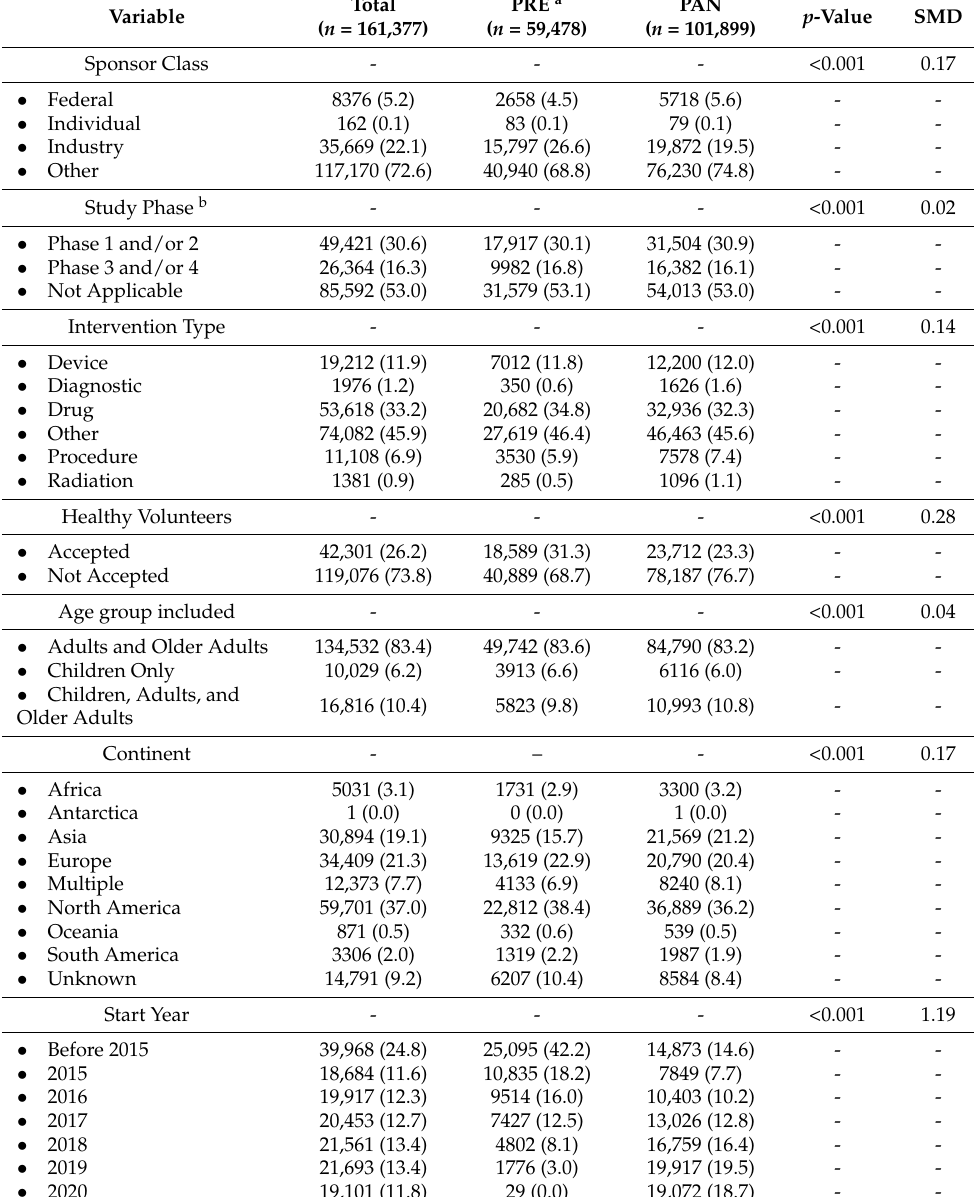
Table 1. Characteristics of the trials in the pre-pandemic (PRE) and pandemic (PAN) era.